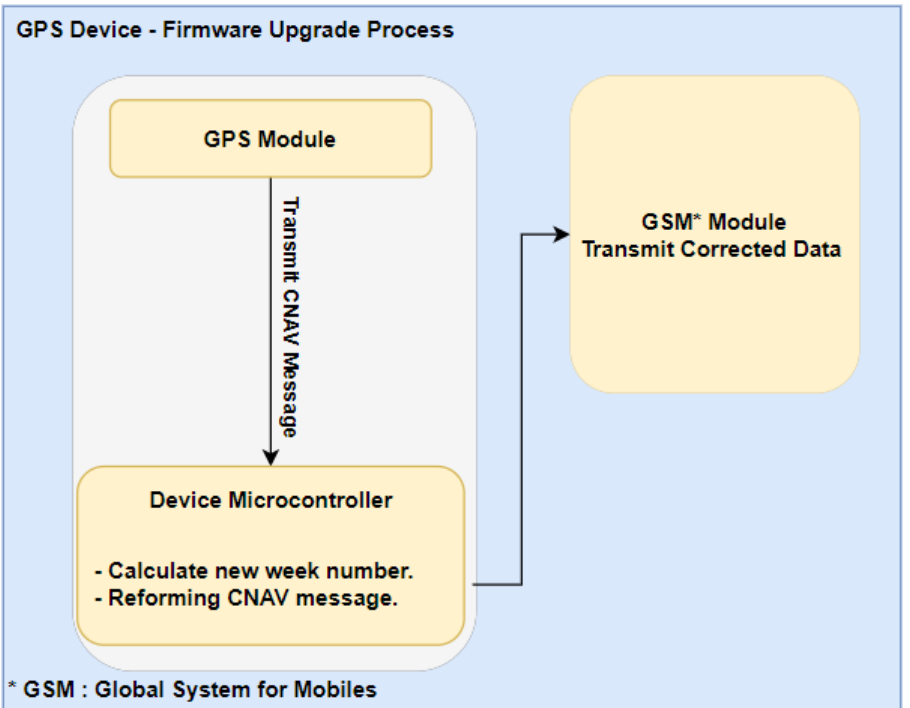
Figure 3. Firmware Upgrade Process.